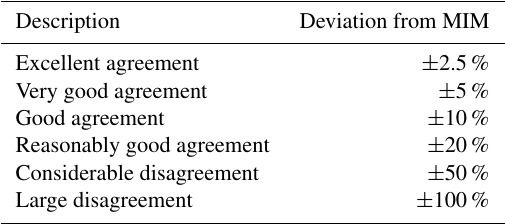
Table 7. Terminology used to define agreement between instru- ments with respect to the multi-instrument mean